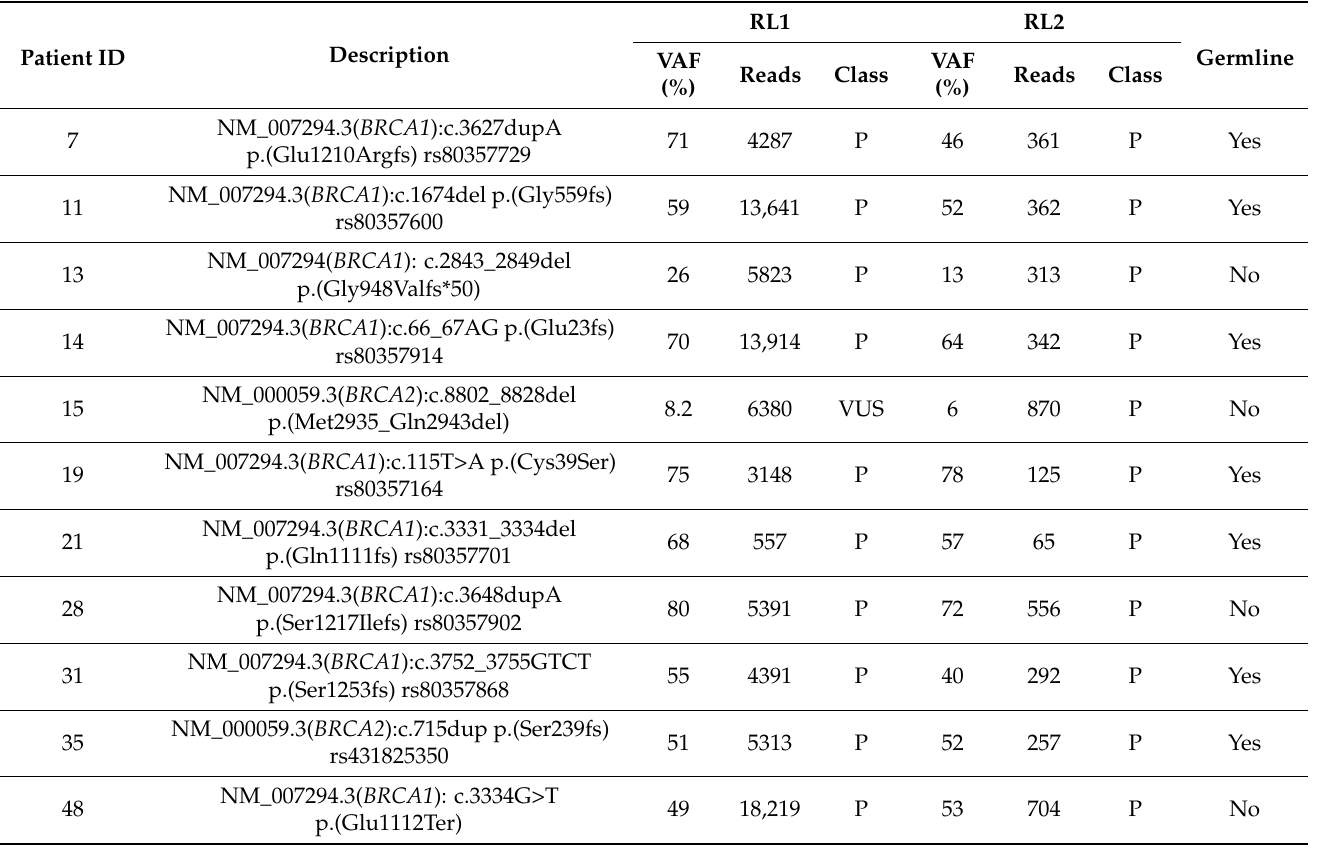
Table 4. Pathogenic and likely pathogenic BRCA1/2 variants detected in EOC